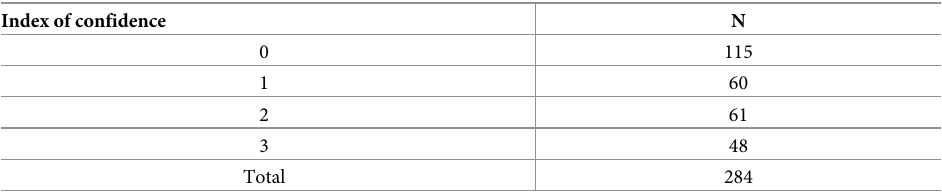
Table 3. Index of confidence �